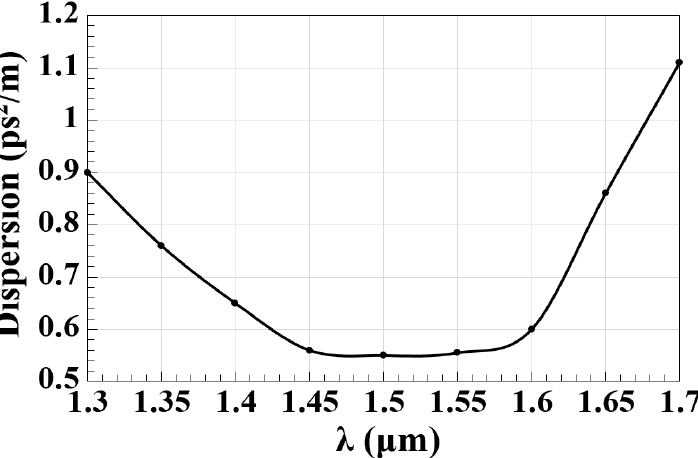
Figure 7. Waveguide dispersion versus operating wavelength ( λ ) utilizing 2 × 2 silicon waveguide.